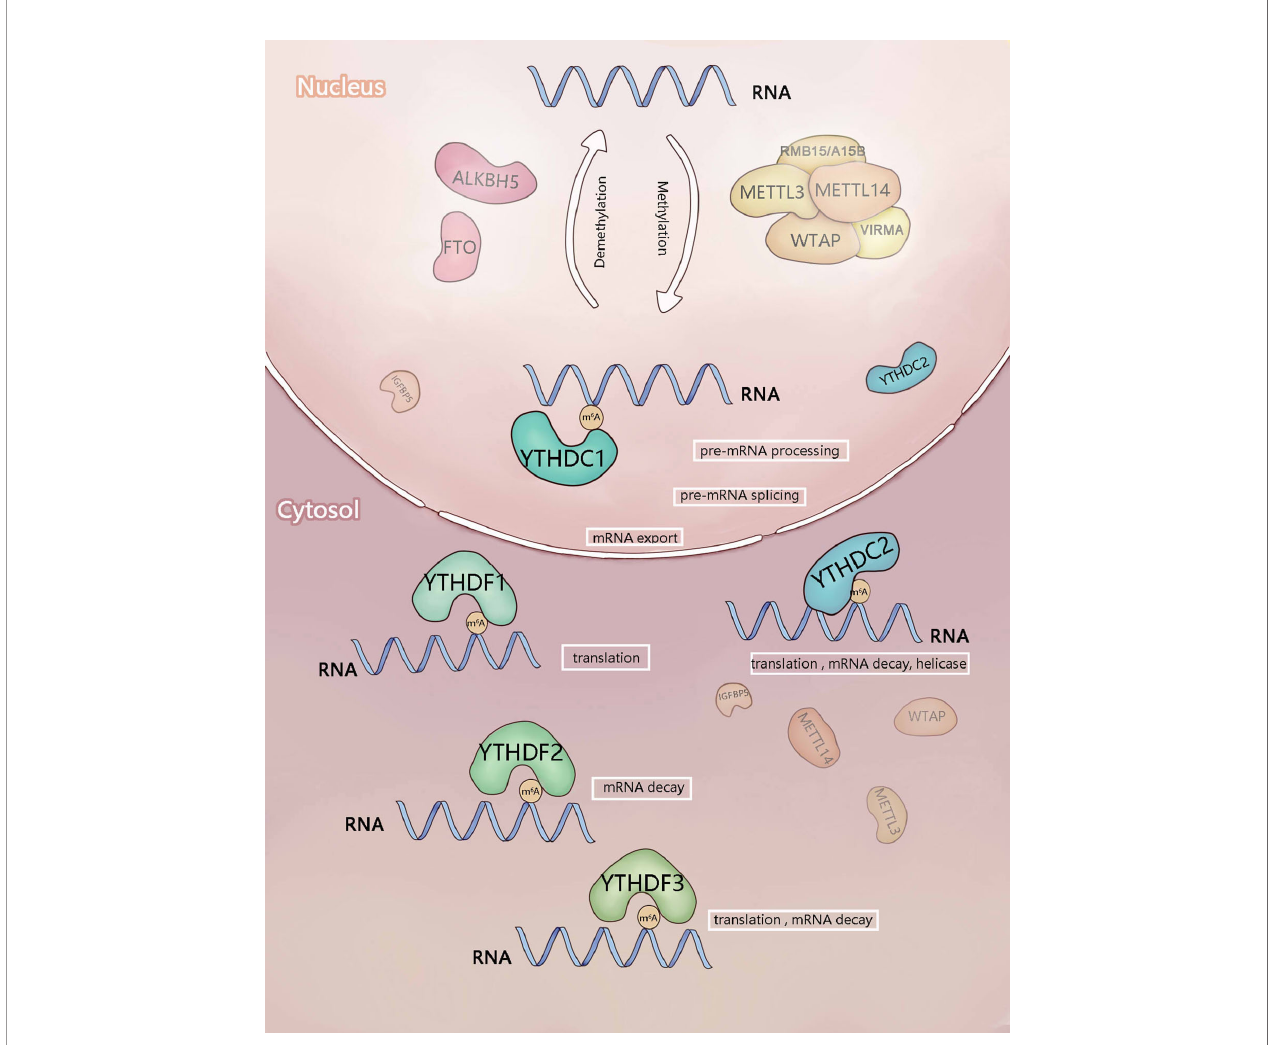
FIGURE 1 | Components involved in m 6 A modi fi cation. m 6 A is mainly added by methyltransferase complex composed of methyltransferase-like3 (METTL3), METTL14),WTAP, RBM15/RBM15B, and VIRMA (writers). ALKBH5 and FTO (erasers) can remove m 6 A as demethyltransferase. In the nucleus, m 6 A can be recognized and regulated by YTHDC1 (reader) to regulate RNA splicing and mRNA export. In the cytosol, YTHDF1-3 and YTHDC2 (readers) recognize m 6 A, then they regulate the translation and stability